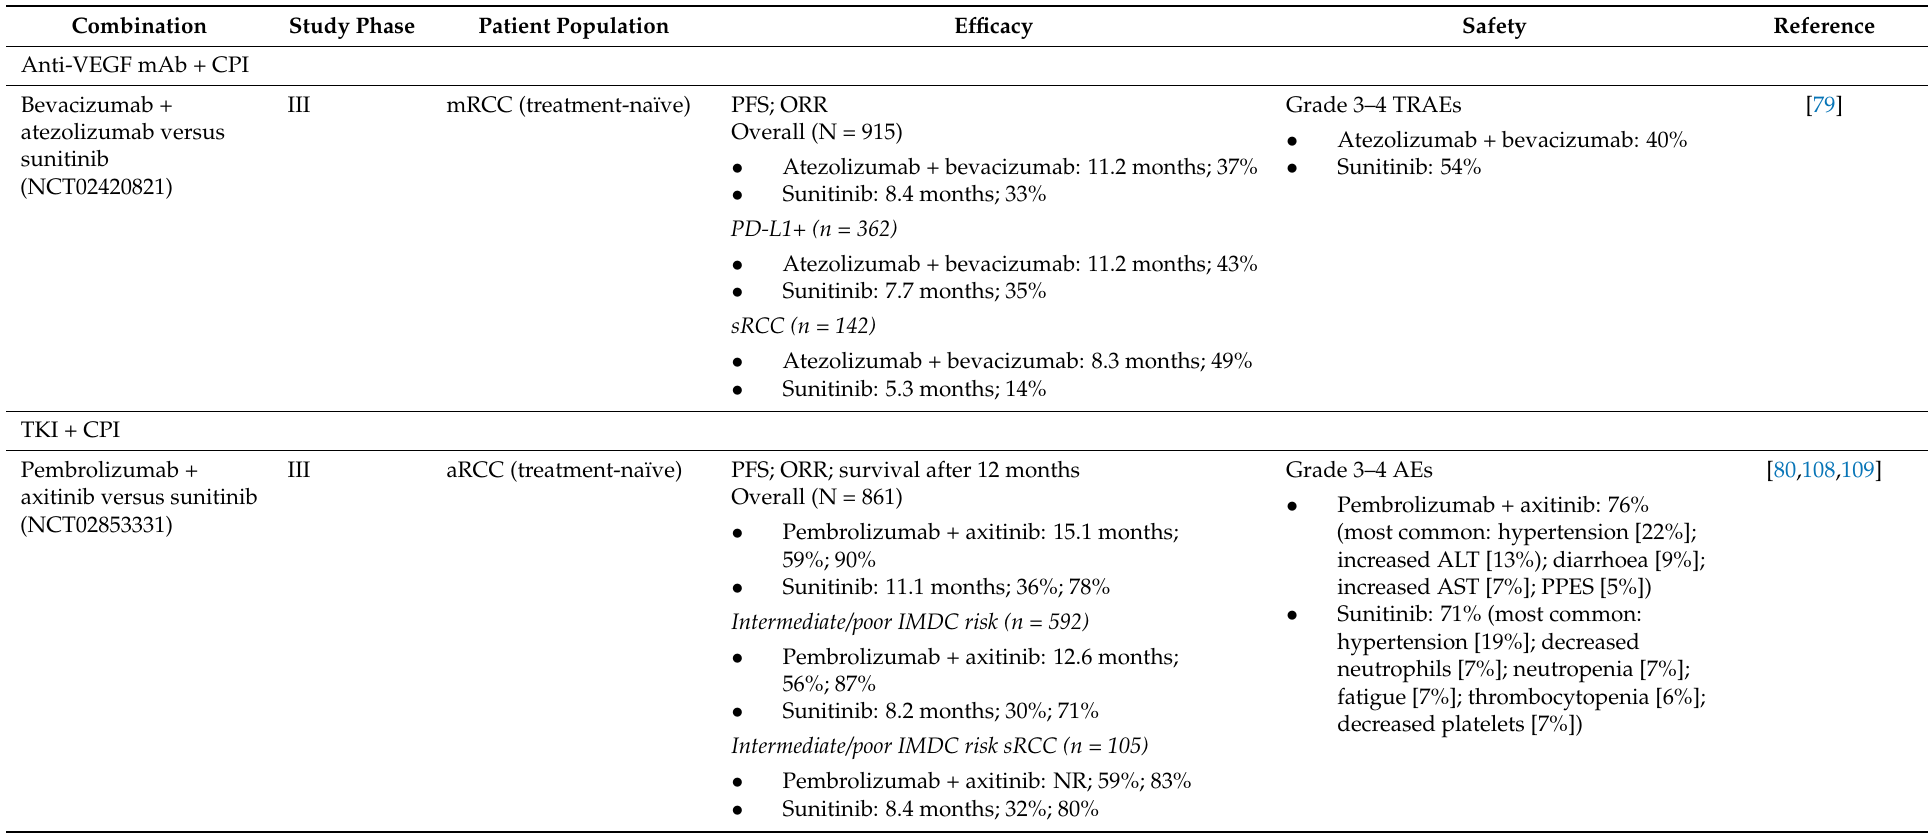
Table 2. Efficacy and safety results reported for phase III trials of TKIs/anti-VEGF mAb plus CPI combinations in patients with RCC. Efficacy Safety